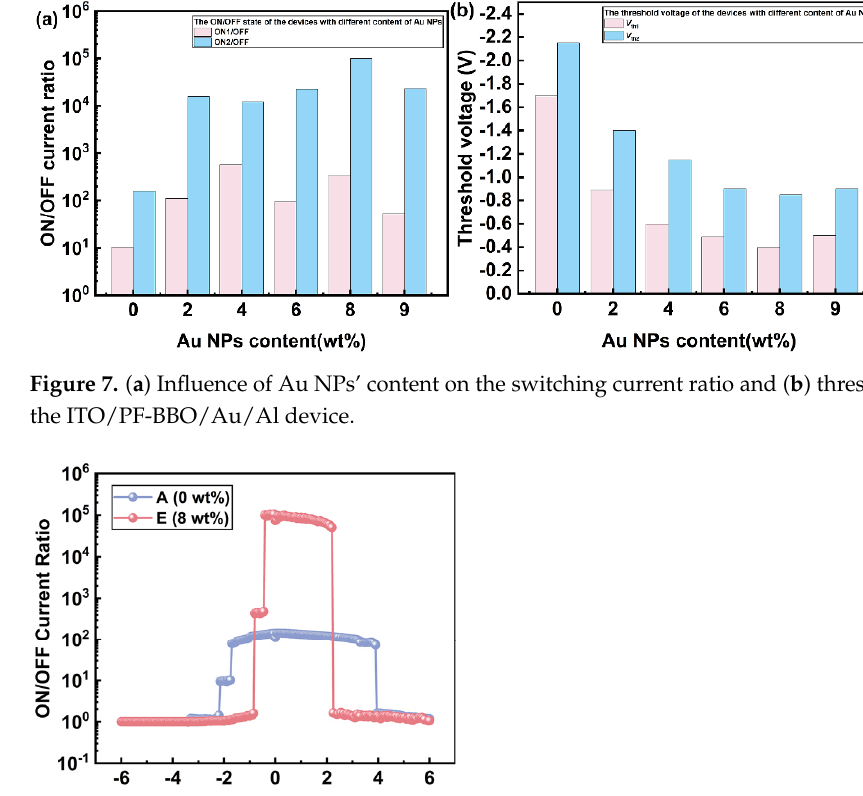
Figure 9. Linear fitting of part log (current) vs. log (voltage) curves: ( a ) ITO/PF-BBO/Al (device A); ( b ) ITO/PF-BBO/Au/Al (device E). The current in the low-voltage region of the log (I) versus log (V) curve recorded from the ITO/PF-BBO/Au/Al device exhibited ohmic conductivity with a slope equal to 1.11 (shown in Figure 9b). As bias voltage is increased, traps caused by structural defects be- come gradually filled, rising to the Fermi level [46]. The corresponding slope equals 1.80. At V = V th1 , the conductivity rapidly rises as a result of the SCLC [47]. During this process, charge carriers fill all traps in the PF-BBO film. The accumulation of additional charges in the PF-BBO film reduces the bandgap [48]. It is worth noting that carriers migrate along the channel with the least resistance, generating the conductive routes of charge-trapping [49]. More conductive carriers appear on the ITO side and accumulate in the Al electrode